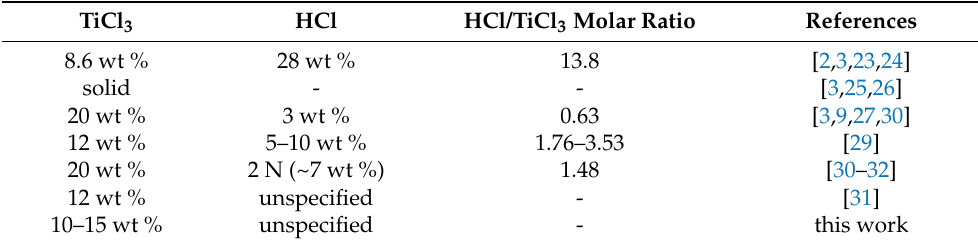
Table A1. TiCl 3 reagent